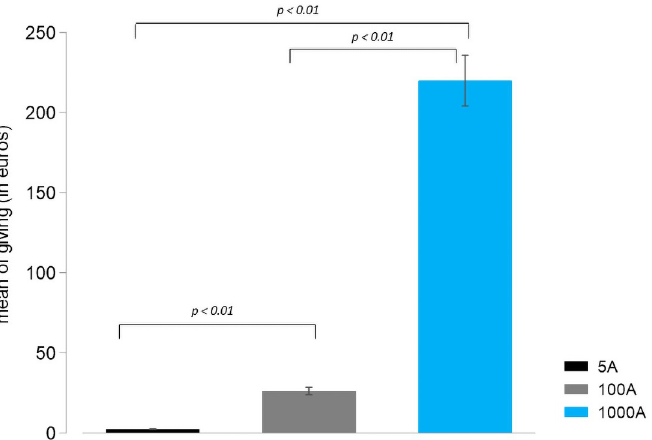
Fig 1. Average giving in the 5 € , 100 € , and 1000 € treatments. Grey vertical lines represent standard errors of the mean.